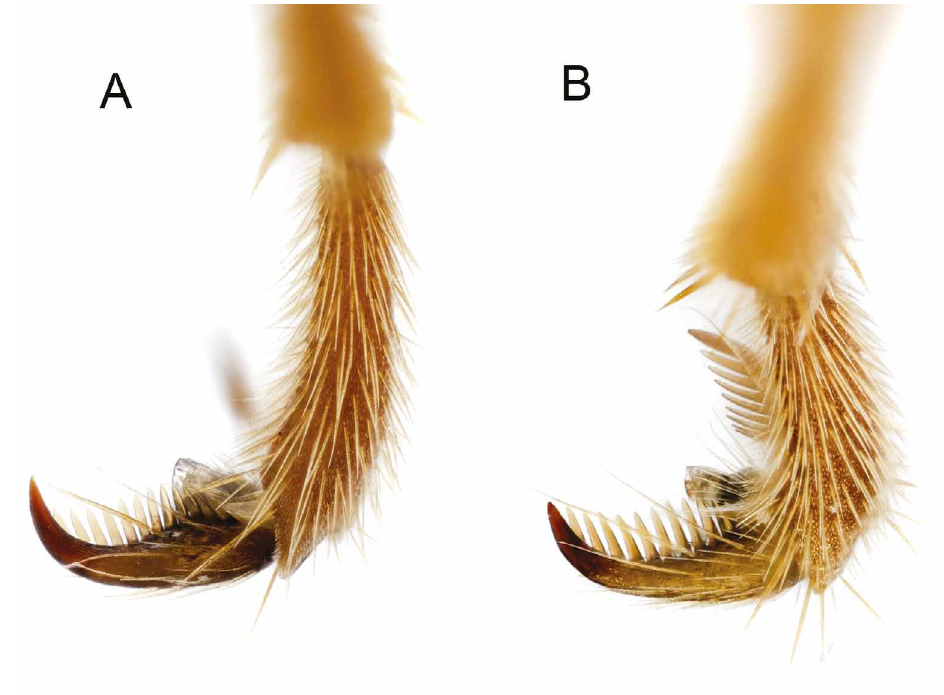
Fig. 15. Hind tarsal claws. A . Enicospilus ramidulus (Linnaeus, 1758), ♀. B . E. adustus (Haller, 1885),